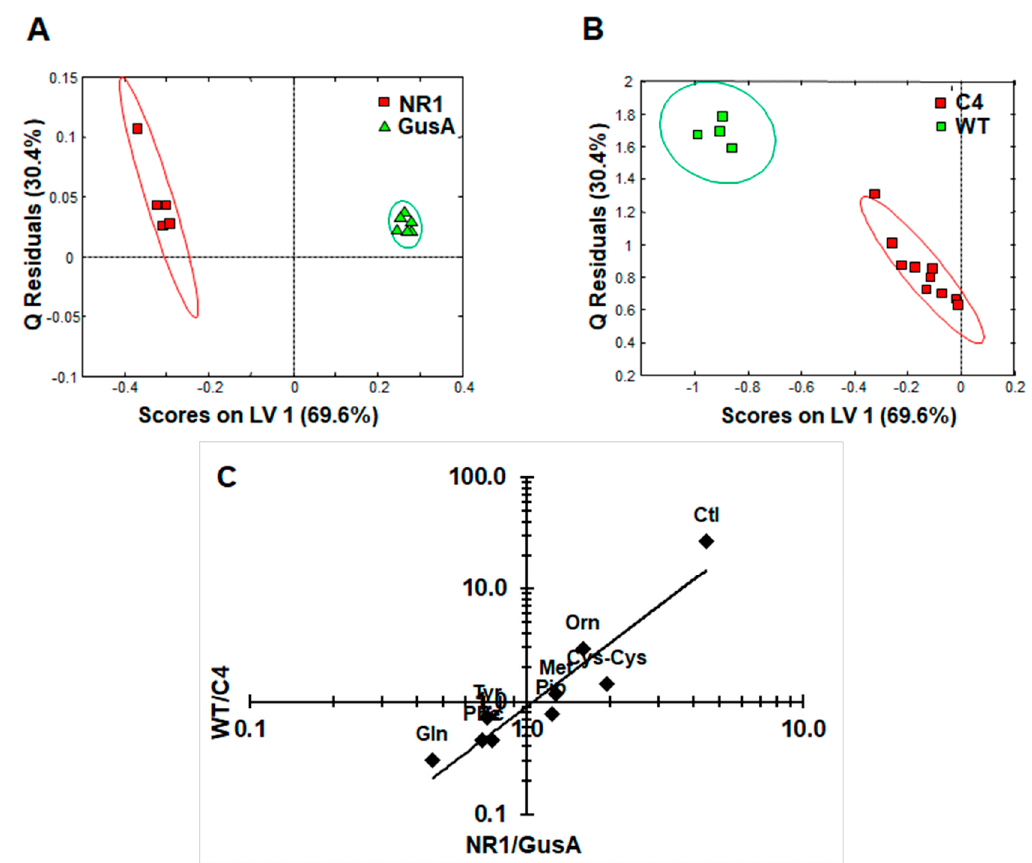
Figure 5. The metabolic pattern obtained by comparing NR1 versus GusA can be linked to the nitro drug susceptibility. ( A ) oPLS-DA score plots displaying the model calculated for distinguishing NR1 from GusA along the latent variable LV 1. ( B ) Class prediction based on the model shown in ( A ) applied to C4 and WT strains. The ellipses show 83.4% confidence intervals. ( C ) Ratios of the peak integrals of the eight differential metabolites listed above from NR1/GusA vs. WT/C4. The correlation between metabolite ratios in G. lamblia NR1 vs. GusA and WT vs. C4 trophozoites (see Table 1) was highly significant (Pearsons correlation coefficient 0.942; p < 0.0005). R 2 and Q 2 values for the oPLS model are given in Table S2.